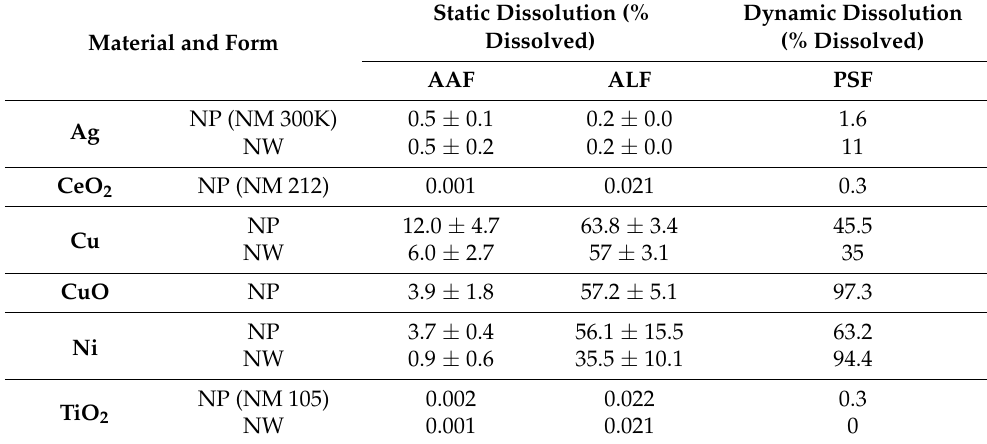
Table 4. Summary of the solubility in biologically relevant model fluids after seven days. AAF: simulant fluid (pH